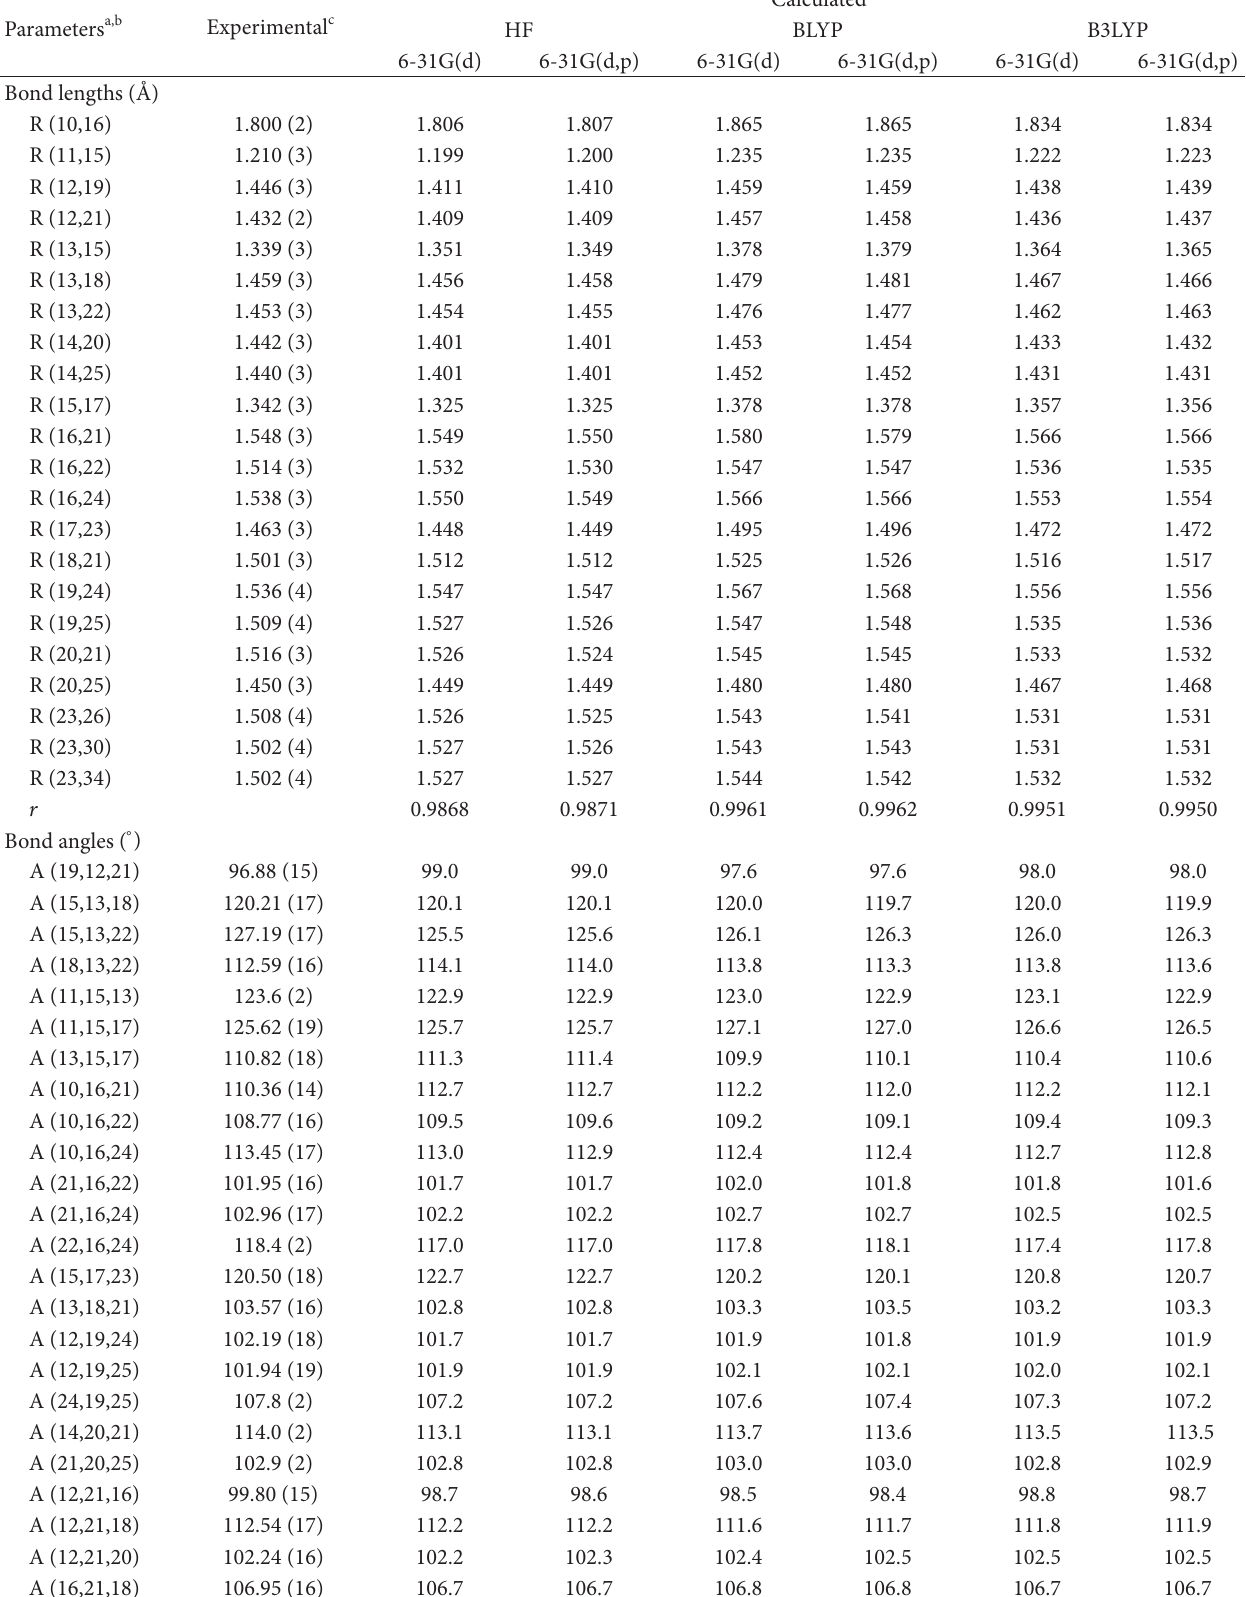
T 2: Optimized and experimental geometries of the title compound in the ground